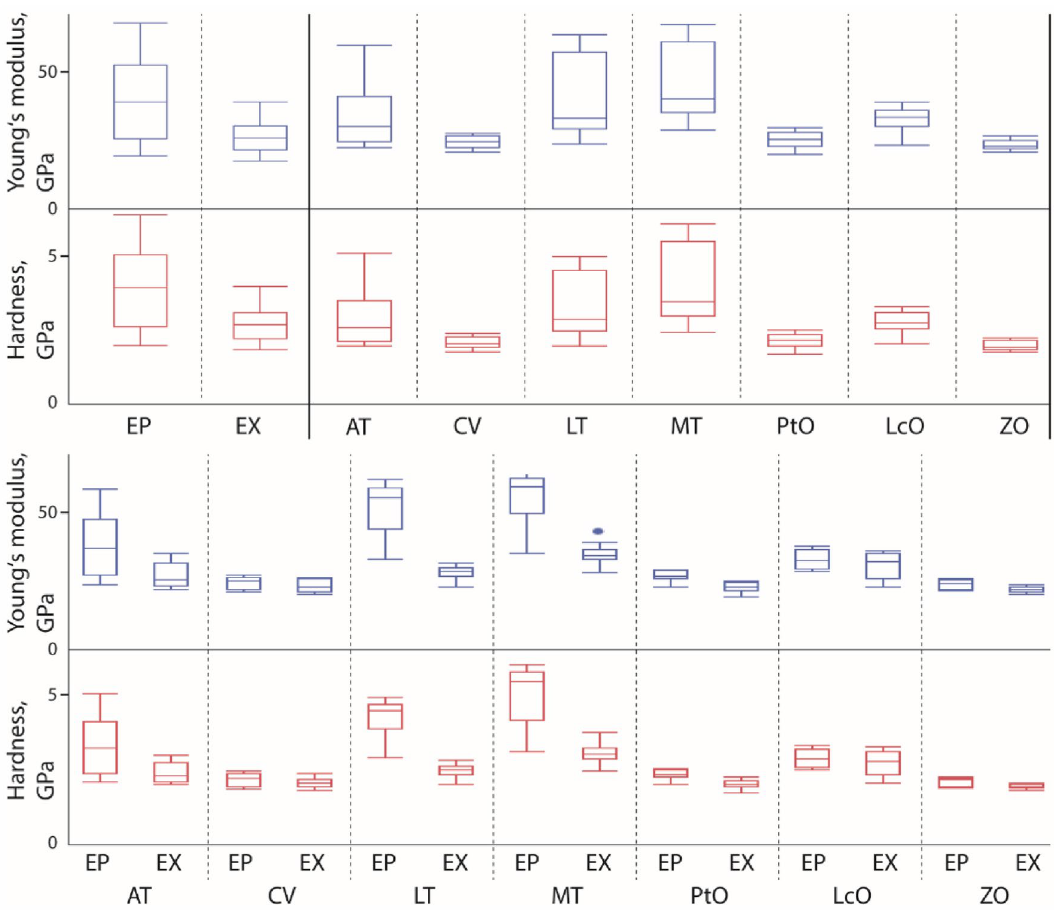
Figure 5. Hardness and Young’s modulus (both in GPa) of the distinct structures and regions tested are shown (for exact values, see Tables 1, 2 and Supplementary Table 1). Above – left: mechanical properties of epicuticle and exocuticle (data for all tested structures are pooled together). Above – right: mechanical properties of epicuticle and exocuticle are pooled together for AT, CV, LcO, LT, MT, PtO, and ZO. Below: mechanical properties of epicuticle and exocuticle separately presented for each structure tested (AT, CV, LT, MT, PtO, LcO, and ZO). AT accessory tooth, CV cardiopyloric valve, EP epicuticle, EX exocuticle, LcO lateral cardiac ossicle, LT lateral tooth, MT medial tooth, M membrane, PtO pterocardiac ossicle, S setae, ZO zygocardiac and many individual elements (Ca, Cl, P, Si), the teeth contained the highest proportions. However, for some elements (F, Fe, Mg, S) this was not the case, which makes the picture rather puzzling (please see Table 3, Supplementary Figs. 2, 3, 4, 5, Supplementary Table 1). When sorting the data on the elemental proportions to the structures and cuticle layer (Table 1 and Supplementary Figs. 4, 5), the epicuticle contained more elements than the exocuticle in most cases. In the membrane however, contents of almost all elements were similar in both epi- and exocuticle. Thus, in most structures the epi- and the exocuticle we found to be distinct in material properties, whereas the membrane seemed to be more homogeneous with regard to the elemental distribution. When sorting the elemental proportions to the different localities (Supplementary Figs. 7, 8, 9, 10, 11, 12), the highest values of Ae were determined (similar to the H and E values) for the (epicuticle of the) medial tooth—at its projections, plates, and the lateral part of the stylus; and for the (epicuticle of the) lateral tooth—at its posterior ridges and anterior cusps (Fig. 6A). From these localities on, the structures became less mineralized. The exocuticle underneath was less mineralized in all localities, but not completely homogeneous (Fig. 6C). The posterior process and the lateral edges of the medial tooth again possessed the highest elemental proportions. Gradients, which could be determined for the epicuticle, could be found in the exocuticle as well, but were not as pronounced. Si was found in high proportions in the (epicuticle of the) medial tooth—at its projections and plates; in the (epicuticle of the) lateral tooth—at its cusps and ridges; and in the (epicuticle of the) accessory tooth—at its tip. In general, Si incorporations were determined at the surfaces of the teeth which interact with the food. In the setae, the tips contained always more Ae and Ca than the bases (Supplementary Fig. 12). Relationship between parameters. Most parameters correlated positively (see Supplementary Tables 3, 4, 5, 6). E and H showed a very high positive correlation (r = 0.99); Ae and Ca, Ae and H, Ae and P, Ae and Si, Ae